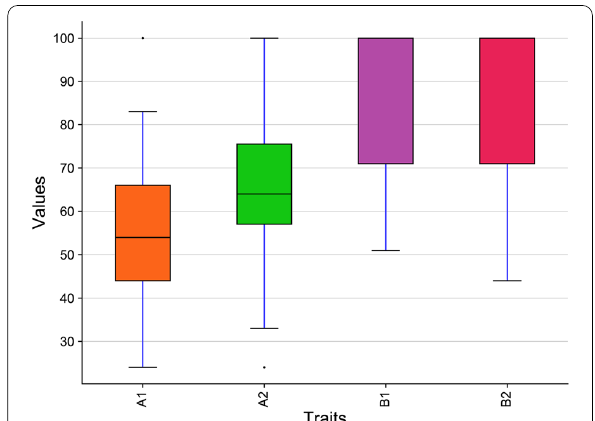
Fig. 1 Box plots indicate the relative reduction of growth rate under both salinity levels of tomato landraces: (A1) relative reduction